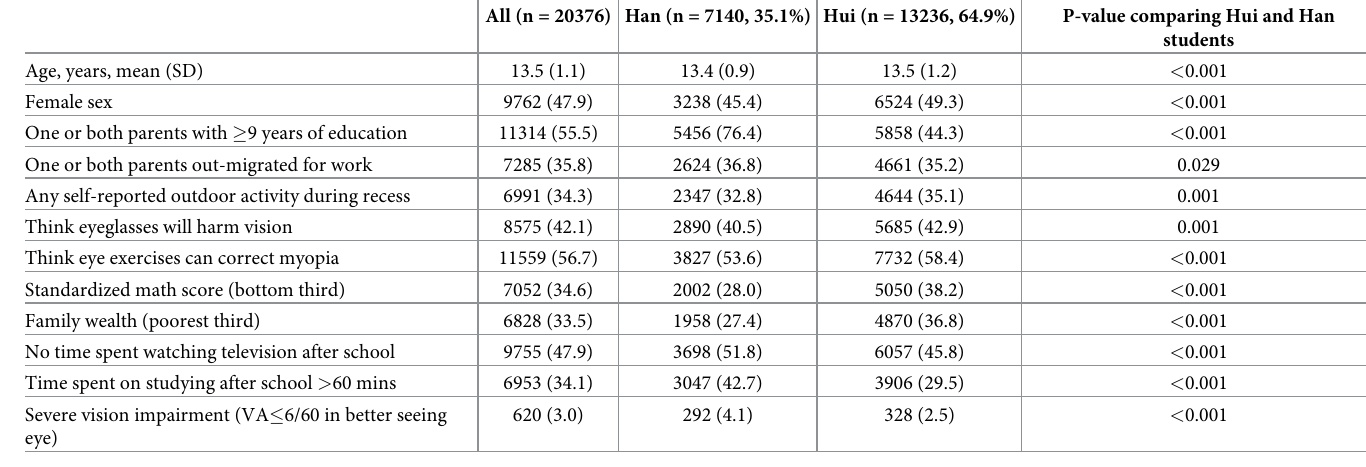
Table 1. Demographic, economic and attitudinal factors potentially predicting visual impairment and glasses ownership, stratified by